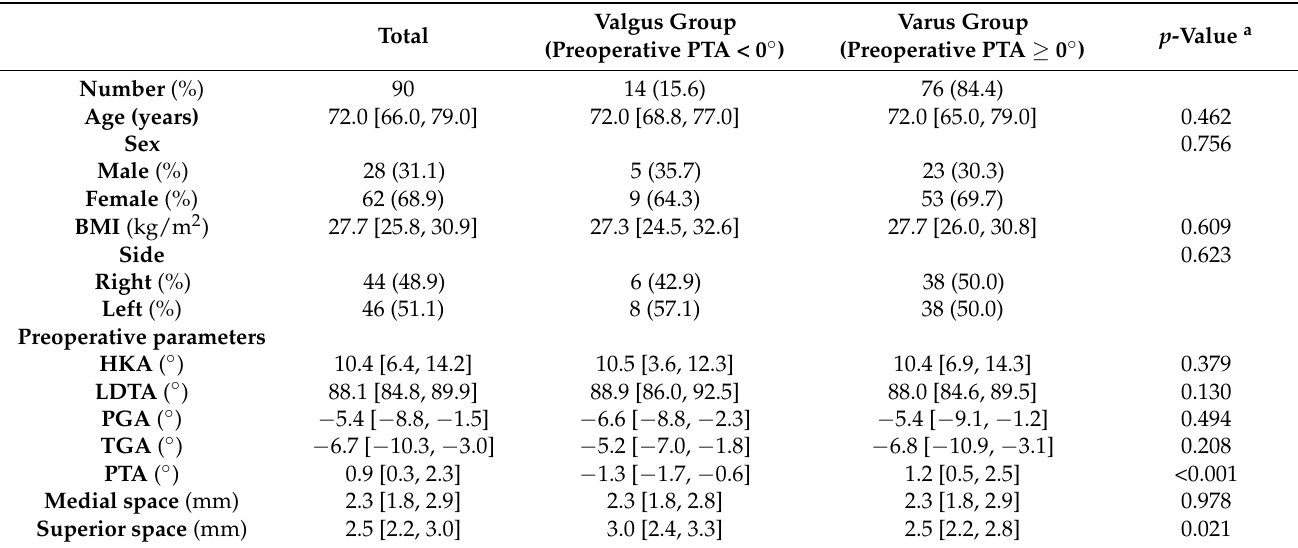
Table 1. Demographic and baseline characteristics of cases.